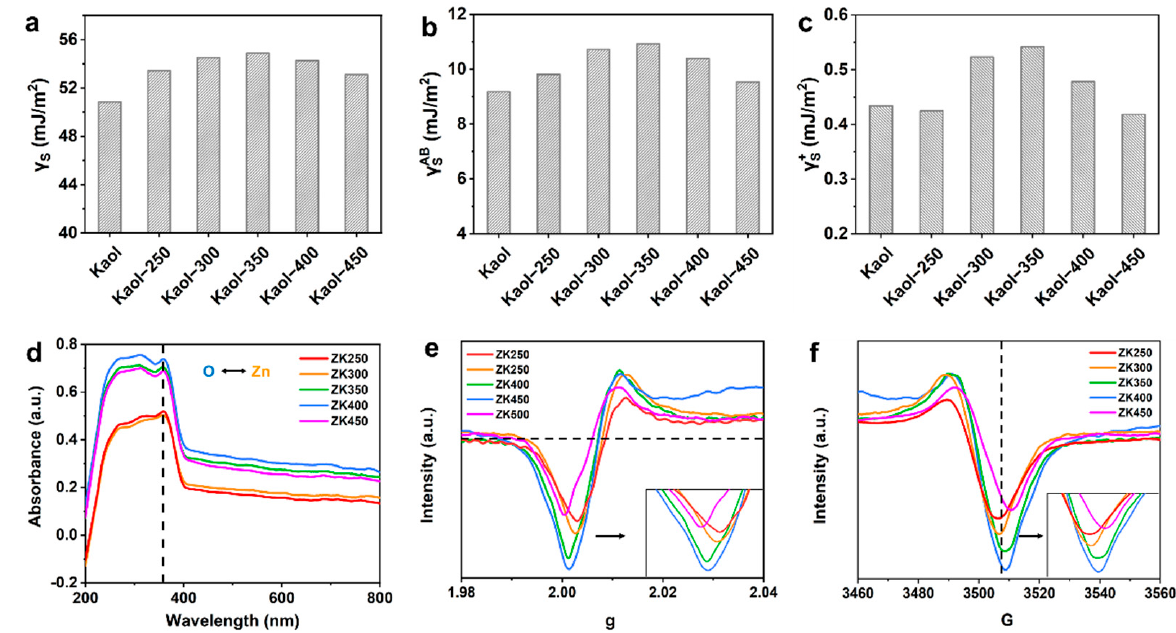
Figure 2. Surface free energy including: ( a ) total surface free energy; ( b ) polar surface free energy and ( c ) Lewis acid surface free energy; ( d ) UV-vis spectra (the black arrow represents the electron transfer between O 2p and Zn 2p). EPR spectra of ( e ) g and ( f ) G of the samples.